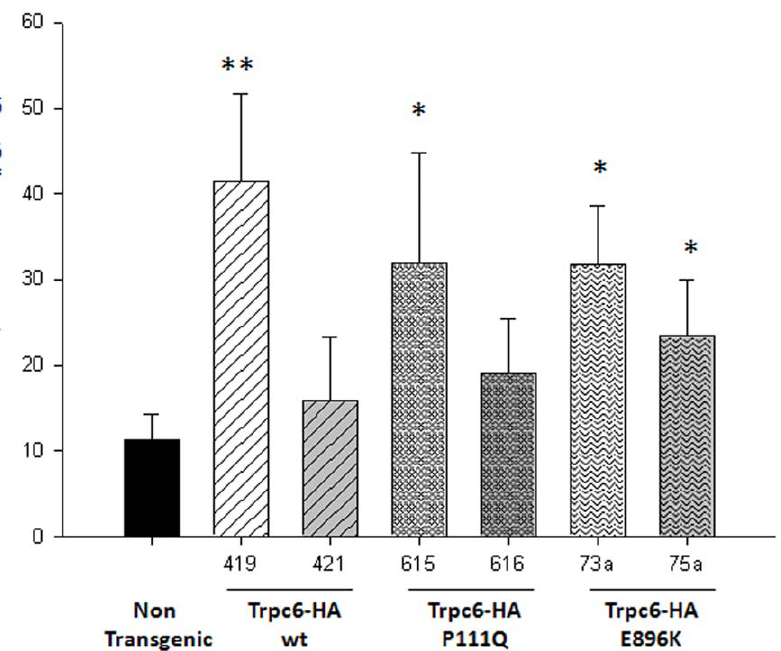
Figure 4. Phenotypic characterization of kidney function in adult transgenic mice. Albuminuria levels ( m g/dL) normalized by creatininuria levels (mg/dL) were tested in male mice at the age of 5–9 months. The number of mice analyzed for each genotype is as follows: non transgenic mice: n=10, transgenic 419 n=9, 421 n=9, 615 n=3, 616 n=13, 73a n=17, 75a n=9. Data are presented in the bars as mean + / 2 SEM. * and ** mean statistical significance using non transgenic mice as control group with a P value , 0.05 and , 0.01, respectively.